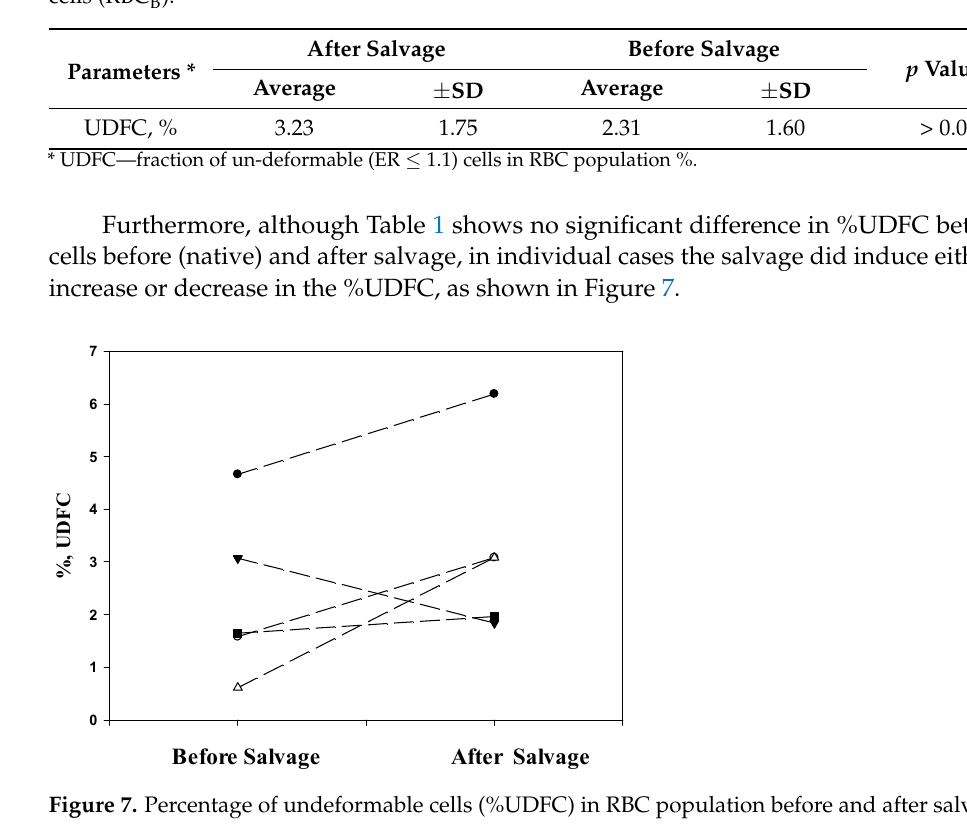
Table 1. Characterizing of RBC deformability for salvaged blood (RBC Sl ) and freshly-collected cells (RBC B ).